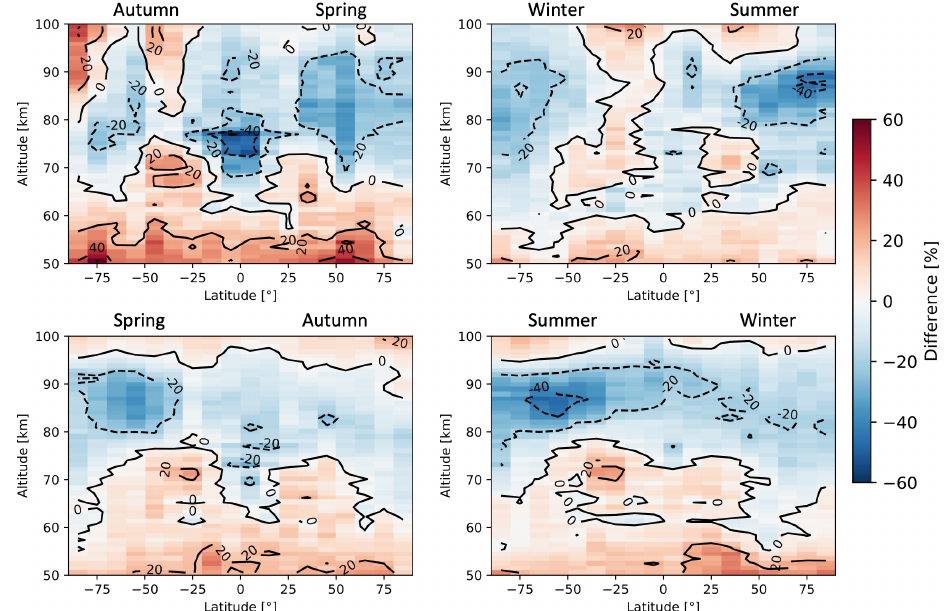
Figure A2. Seasonal zonal means of SMR–MIPAS middle atmosphere relative differences averaged over the time period indicated in Table 2. The seasons are intended as the time between the solstice and the